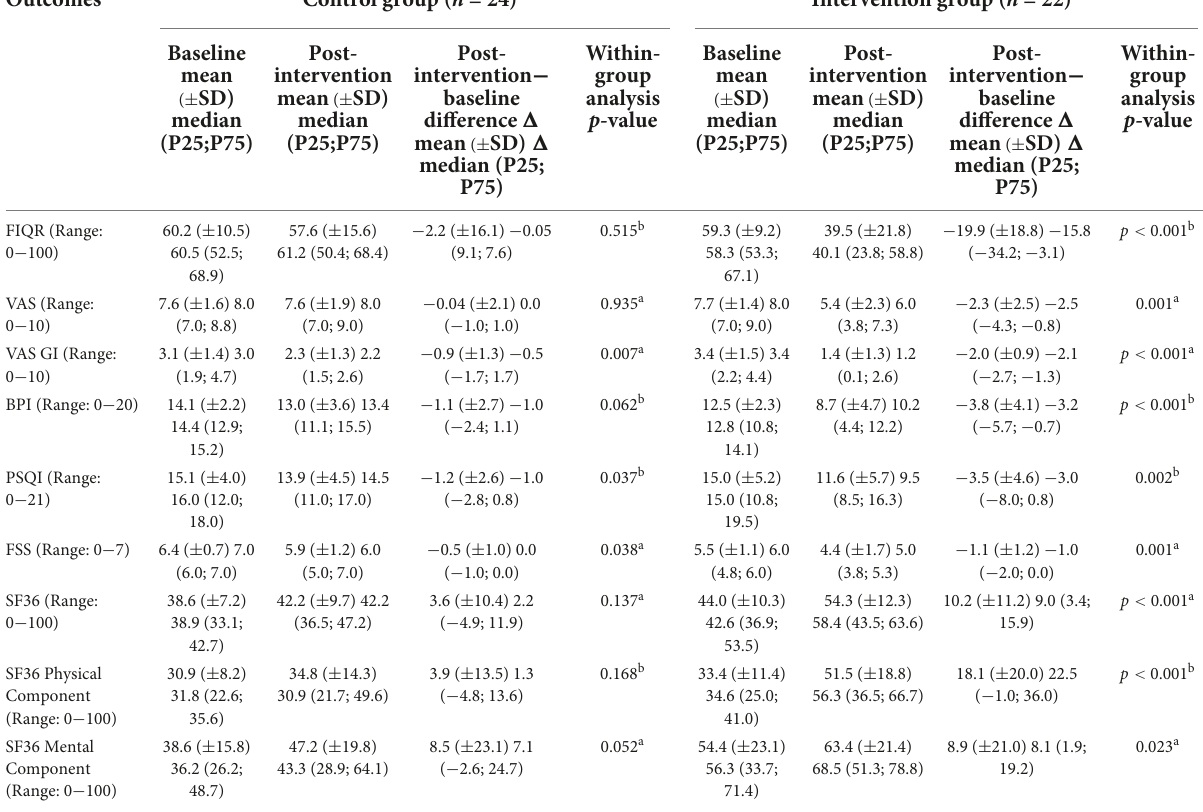
TABLE 4 Clinical features in control and intervention groups at baseline and post-intervention.